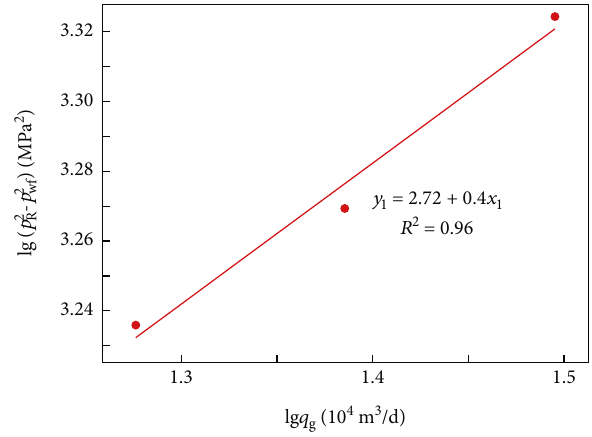
Figure 5: Productivity curve of L2-3 using empirical method. Table 5: Calculation parameters of numerical simulation